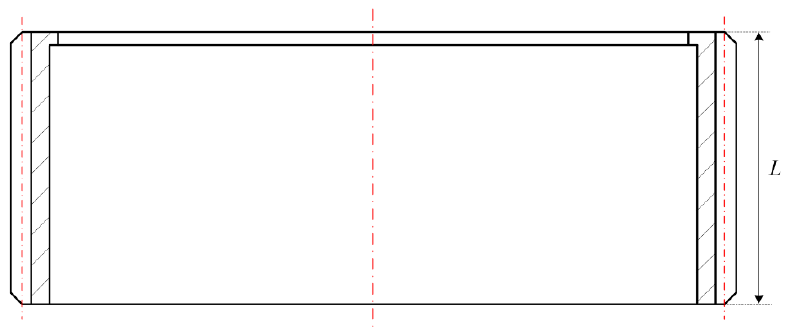
Figure 1. Conventional cup harmonic drive.